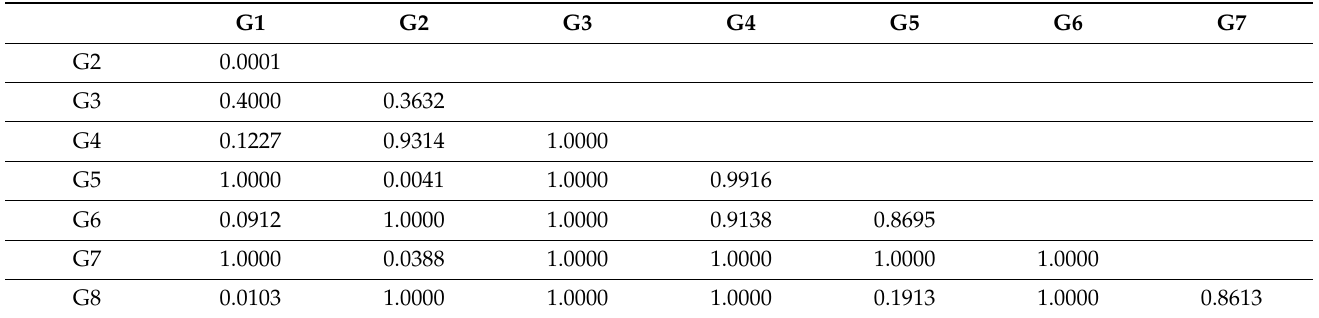
Table 4. p -value following the Dunnet t